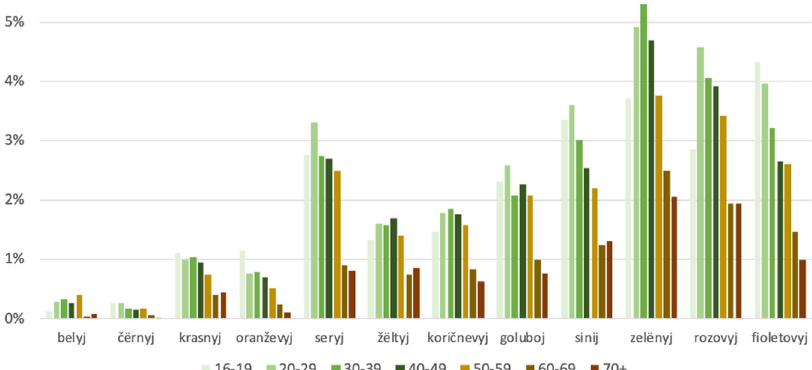
Fig. 7 Percentage of occurrences of the 12 Russian BCTs in different age groups. The BCTs are ordered according to the response frequency, from lowest (left) to highest